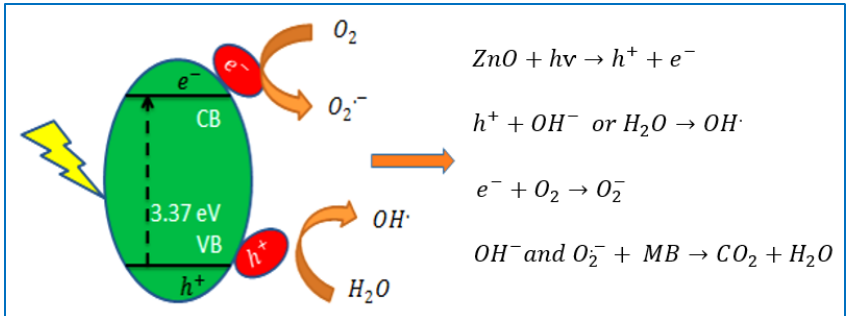
Figure 6. Mechanism of photocatalytic self-cleaning action of ZnO nanoparticles.